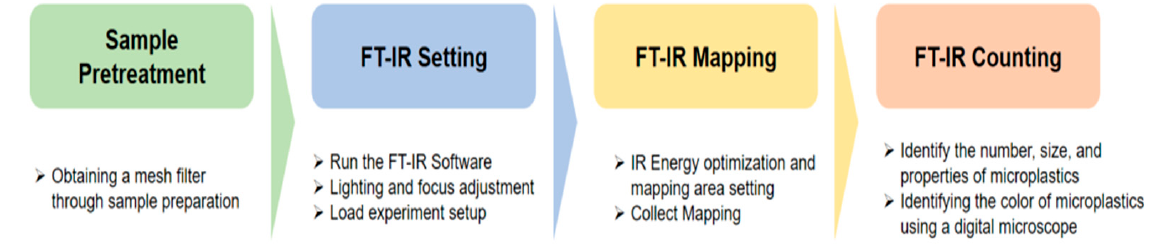
Figure 4. Process of microplastic analysis process using FTIR microscope.